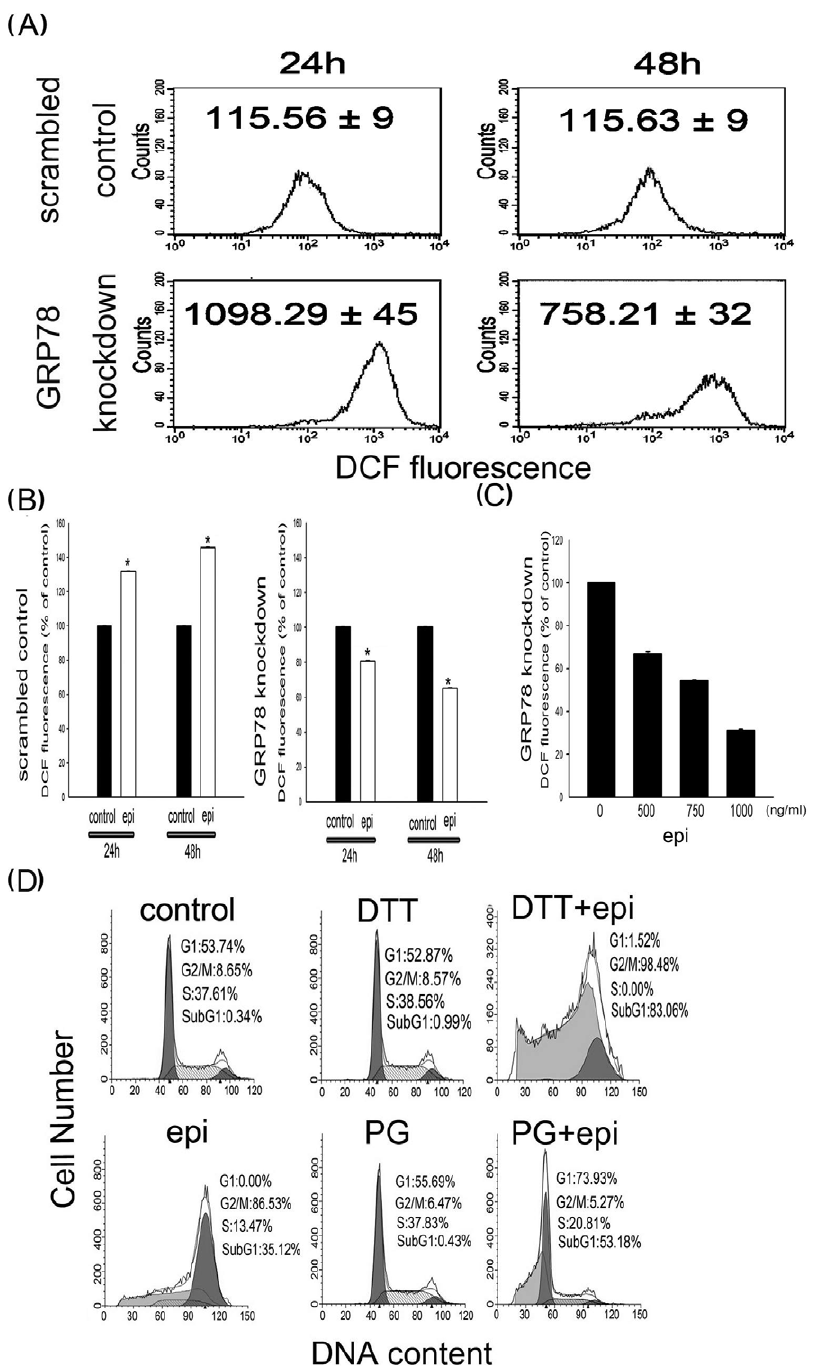
Figure 2. The effect of intracellular oxidative stress on epirubicin (epi) treatment. Scrambled control and GRP78 knockdown DLD-1 cells were (A) cultured for 24 and 48 h or (B) treated with epirubicin (500 ng/ml) for 24 or 48 h. (C) GRP78 knockdown DLD-1 cells were treated with epirubicin (500, 750, 1000 ng/ml) for 48 h. Intracellular ROS were evaluated by DCFH-DA staining and flow cytometry as outlined in the Materials and Methods . (D) Scrambled control DLD-1 cells were treated with 500 ng/ml epirubicin (epi) alone, 25 m M propyl gallate (PG) alone, 1 mM dithiothreitol (DTT) alone or epirubicin combined with PG or DTT for 48 h . The percentages of cells that were in the subG 1 phase (indicated by DNA damage) were determined as outlined in the Materials and Methods . The values are represented as the mean 6 standard deviation (n=5–8) of the individual experiments. A significant difference from the control group was set at P , 0.05 (*).